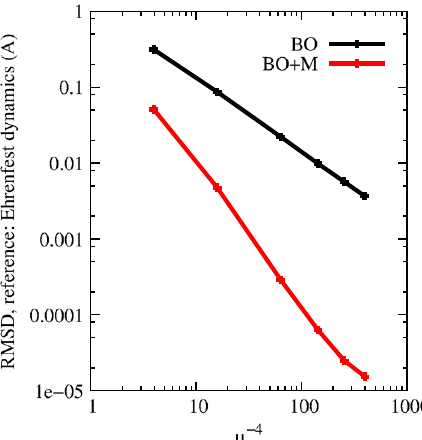
FIG. 7. Root-mean-squared deviations of the O ─ O distance between Ehrenfest results and the BO approximation (black) or the BO approximation corrected by the position-dependent dressed mass (red). The results are shown as functions of the inverse mass ratio μ − 4 . The comparison shows that orders of magnitude in accuracy are gained with respect to the BO approximation, when the position-dependent mass correction is taken into account.